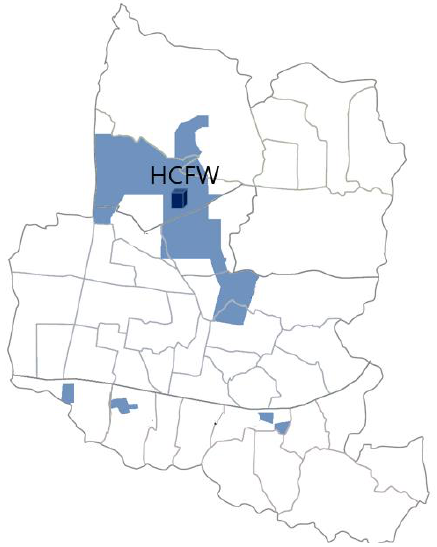
Figure 2. Small businesses and health centers for workers (HCFW) locations in B area.